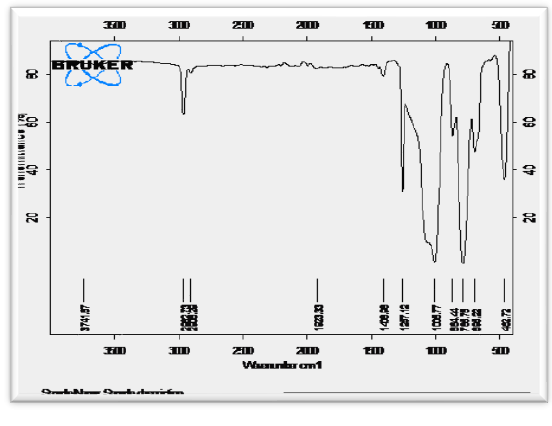
Figure 1: the FTIR of the VST 50F maxillofacial silicone before addition of Al 2 O 3 Nano fillers